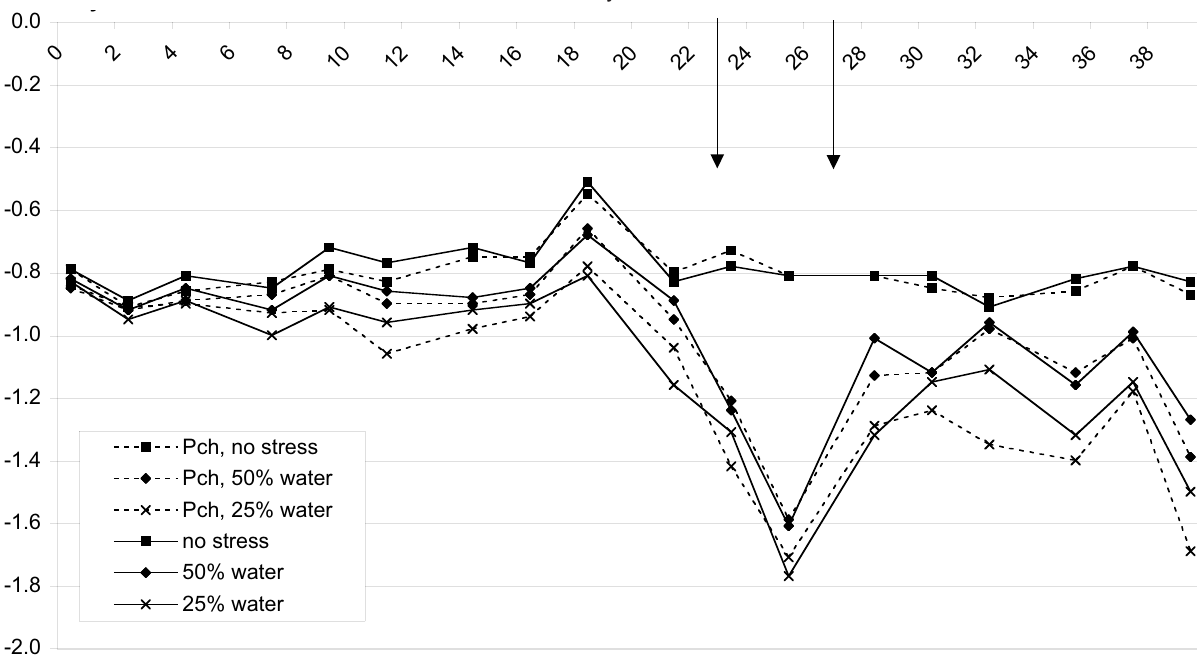
Fig. 2. Effect of water stress on leaf water potential of infected and uninfected Cabernet Sauvignon, November 2005. The arrows indicate the period when water was completely withheld from the stress